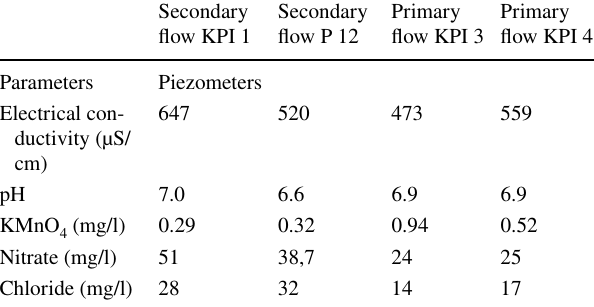
Table 1 Chemical composition of groundwater flows (primary and